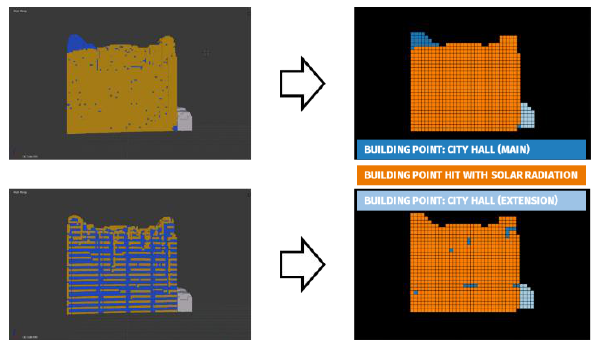
Figure 15. Screenshot of Model to Gridded Image Figure 16 for